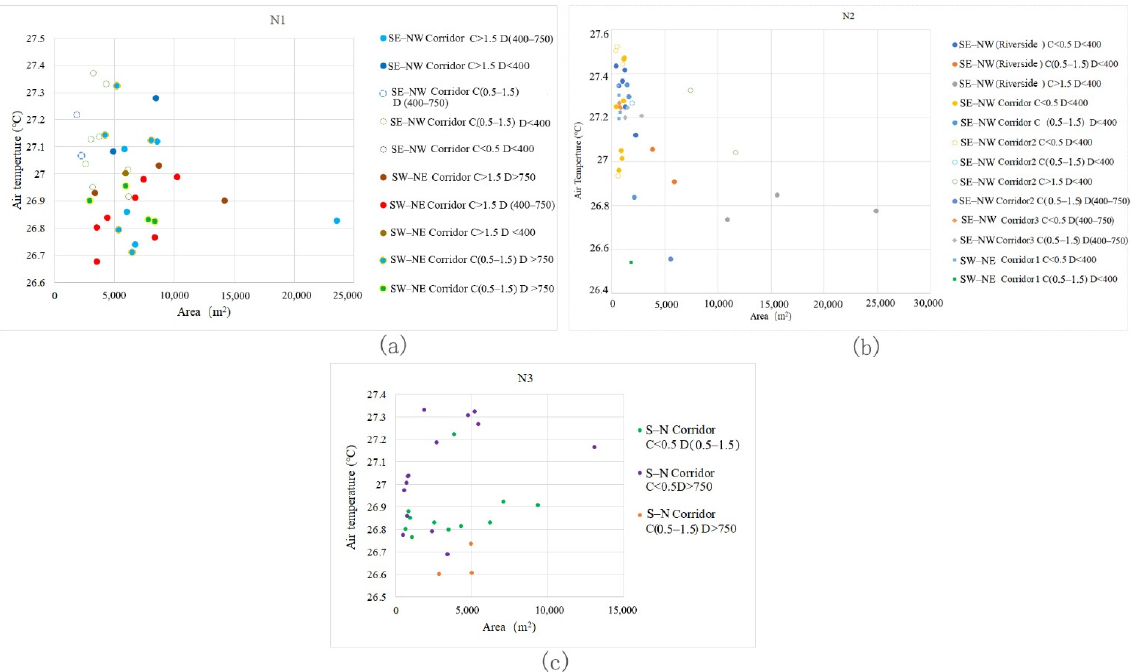
Figure 15. Scatter diagram of spatial connectivity and corresponding temperature distribution of green corridors. ( a ) In block 1, most of the T values corresponding to the green corridors with C > 1.5 are below the connectivity grade where C is 0.5–1.5 and C < 0.5, that is, the connectivity is large and the corresponding Ta value is low. ( b ) In block 2, the relationship between connectivity and Ta in the riverside green corridor segments is particularly significant. The higher the grade of C values, the lower the Ta values. In addition, compared with the group data of two grades of green corridors with C > 1.5 and C of 0.5–1.5, most of the Ta values corresponding to C > 1.5 are in the middle and lower part of the chart and most of the Ta values corresponding to C < 0.5 are in the upper part of the chart. ( c ) In block 3, the Ta values of green corridors with C < 0.5 are mostly in the upper part of the chart and the C values of the green corridors are in the range of 0.5–1.5, which are located in the low Ta values.